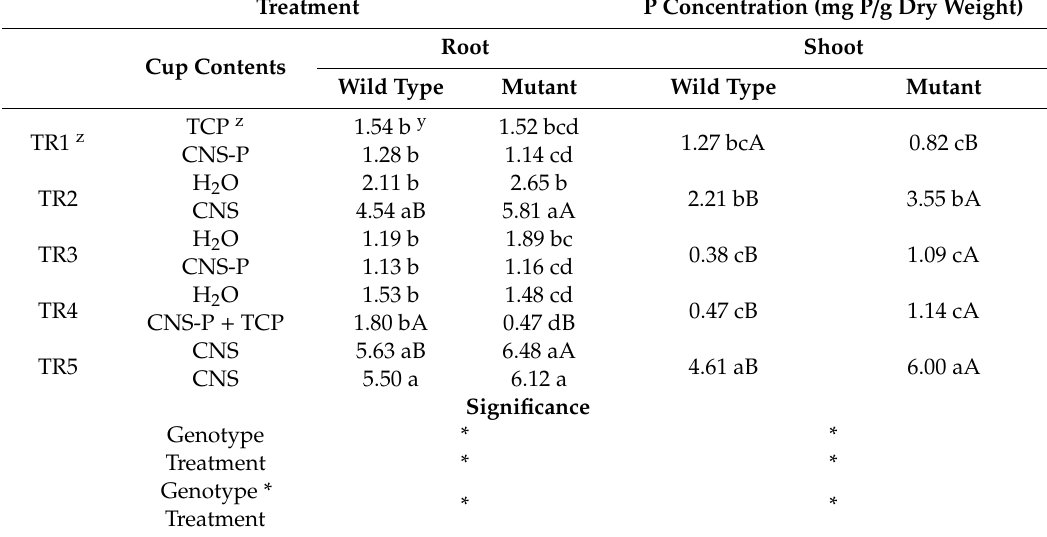
Table 3. Root and shoot P concentrations in two barley genotypes with selected P treatments in a split-root